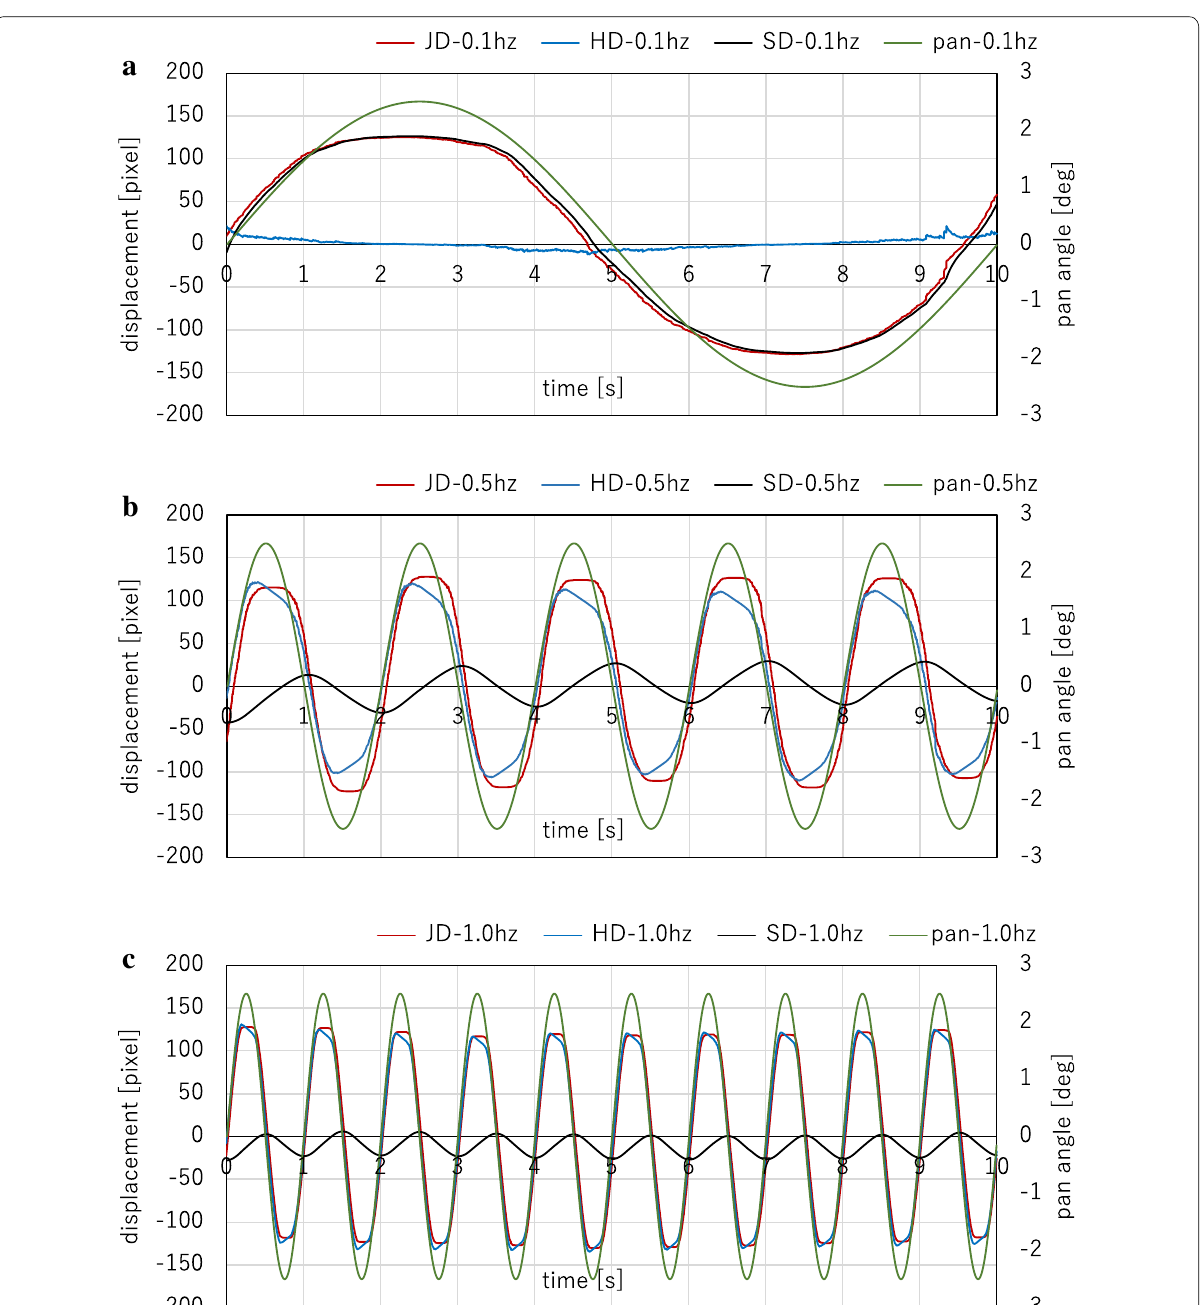
Fig. 6 Pan angles, jitter displacements (JDs), filtered high-frequency components (HDs), and stabilized displacements (SDs) when a hybrid-camera system vibrated at: a 0.1 Hz, b 0.5 Hz, c 1.0